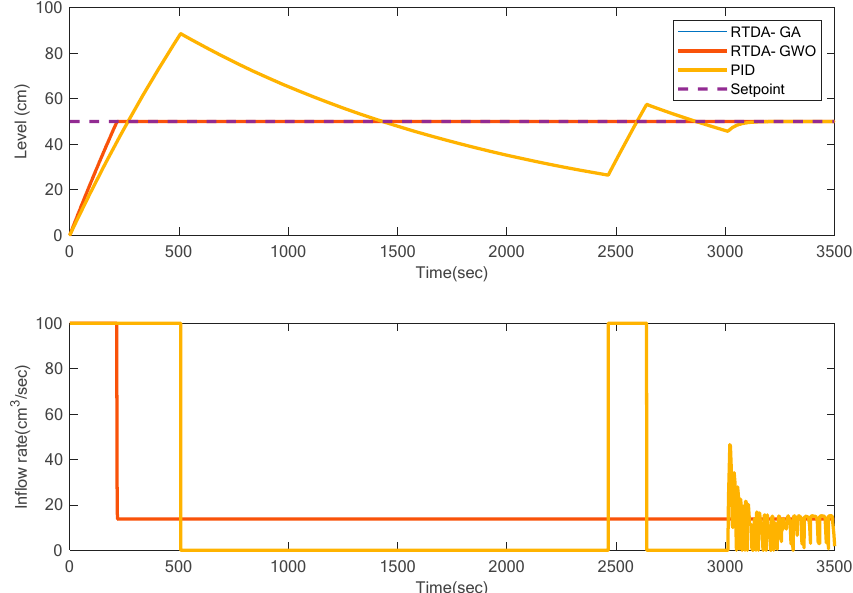
Figure 11. RTD-A and PID controlled level of conical tank for h = 50 cm.